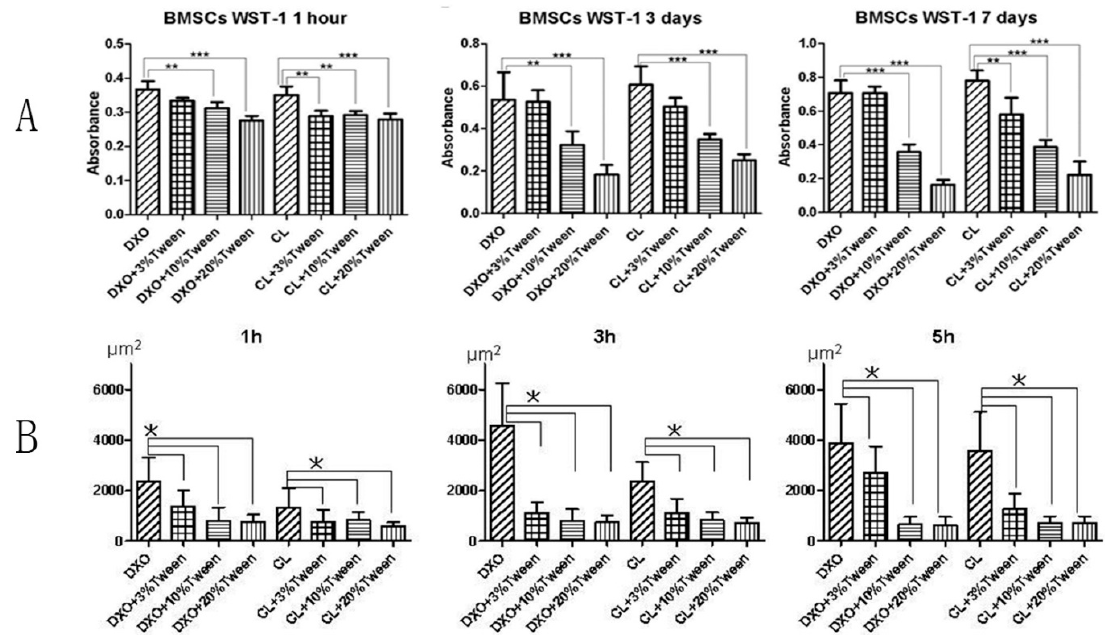
Figure 3. ( A ). WST-1 results after 1 h, 3 days, and 7 days. (** p < 0.05, *** p < 0.01). 3% Tween 80